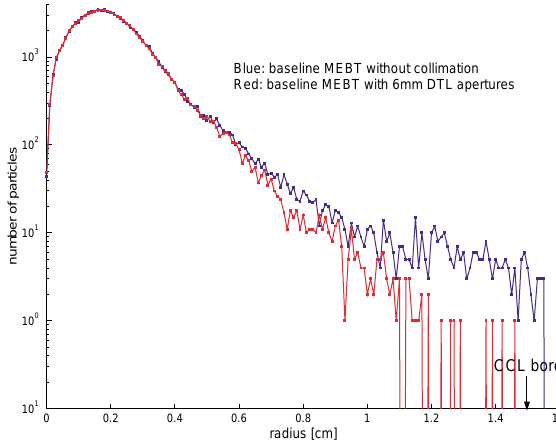
FIG. 18. (Color) Radial beam distribution at 171 MeV with and without DTL collimation. DTL collimators of 8 mm radius do not reduce beam halo.